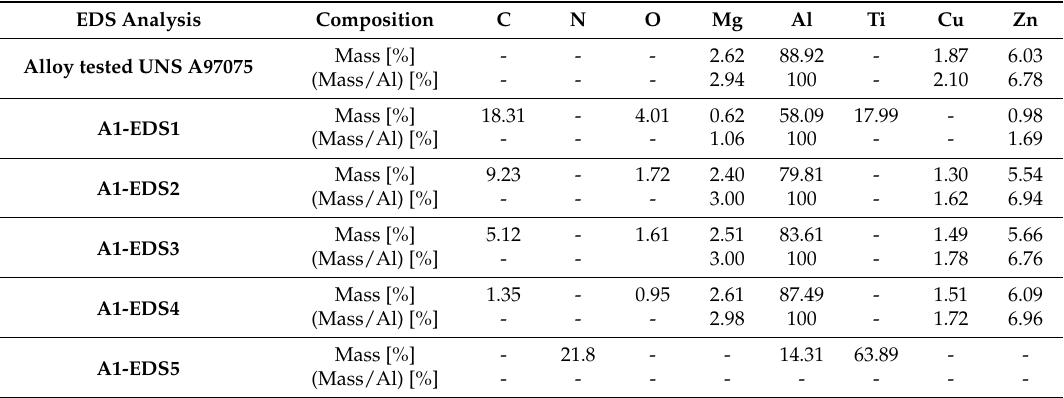
Figure 9. SEM image from A1 (the analyzed points are marked). Table 4. Composition from EDS analysis (A1).